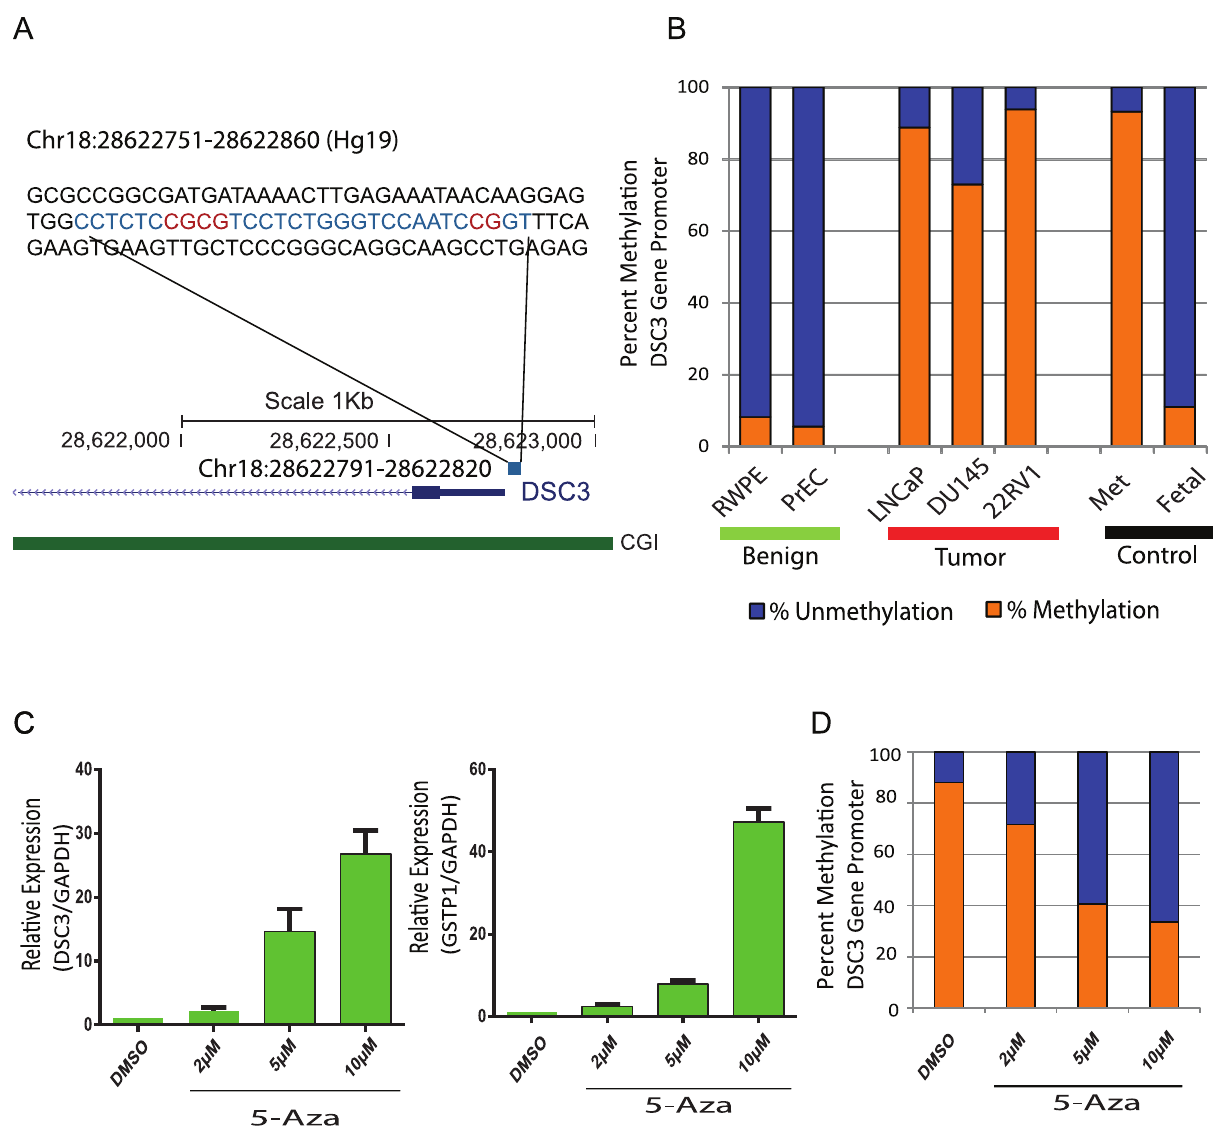
Figure 3. Hypermethylation of DSC3 Promoter in PCa Cell Lines. (A) Sequence of the DSC3 promoter (Chr18:28622751-28622860) and the region analyzed by pyrosequencing are given in blue (Chr18:28622791-28622820) and the CG positions monitored within are indicated in red. CGI, CpG island. (B) Bar plot depicts the average of the percent methylation in the three CG positions in prostate cell lines. Blue-percent unmethylation; Orange-percent methylation; Bi-sulfite converted universally methylated gDNA and fetal DNA were used as positive and negative controls respectively. (C) DSC3 expression as assessed by Q-PCR in LNCaP cells treated with 5-Aza-deoxycytidine (5-Aza), GSTP1 was included as a positive control. (D) Bar plot depicts the average of the percent methylation in the three CG positions in LNCaP treated with